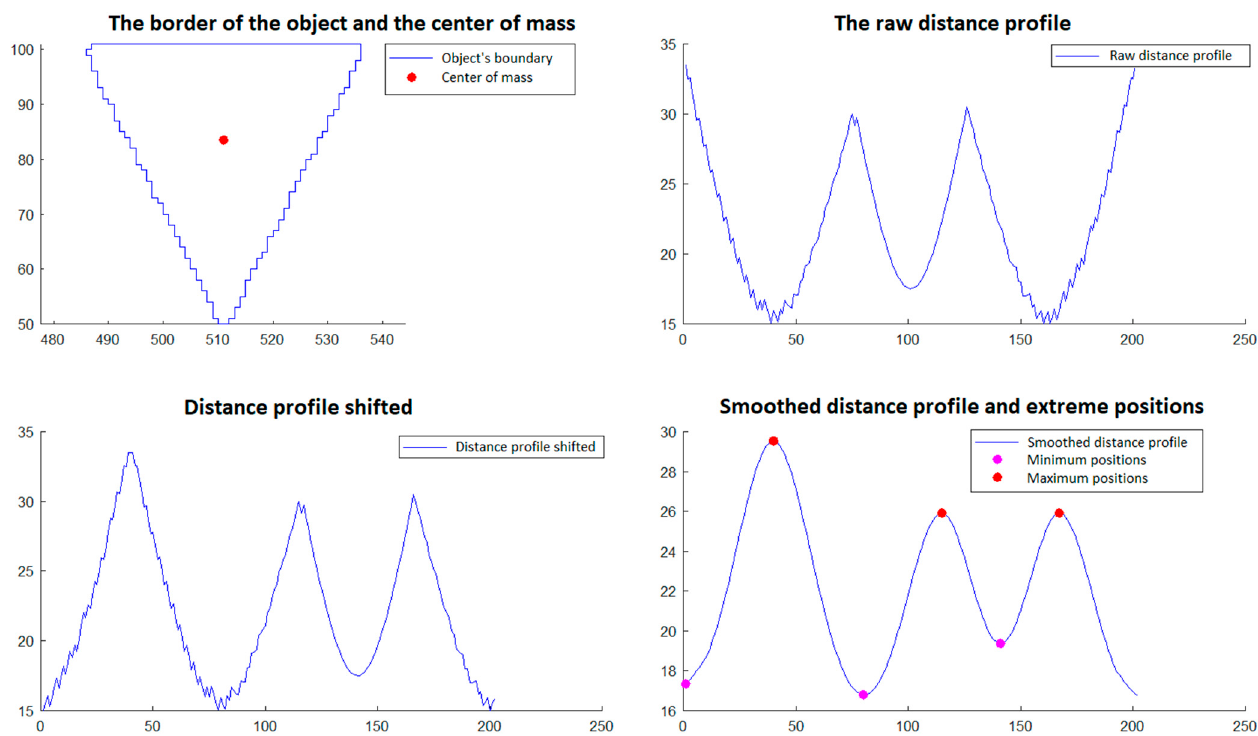
Figure 12. Triangular object selection procedure (step 5)—South triangular object.